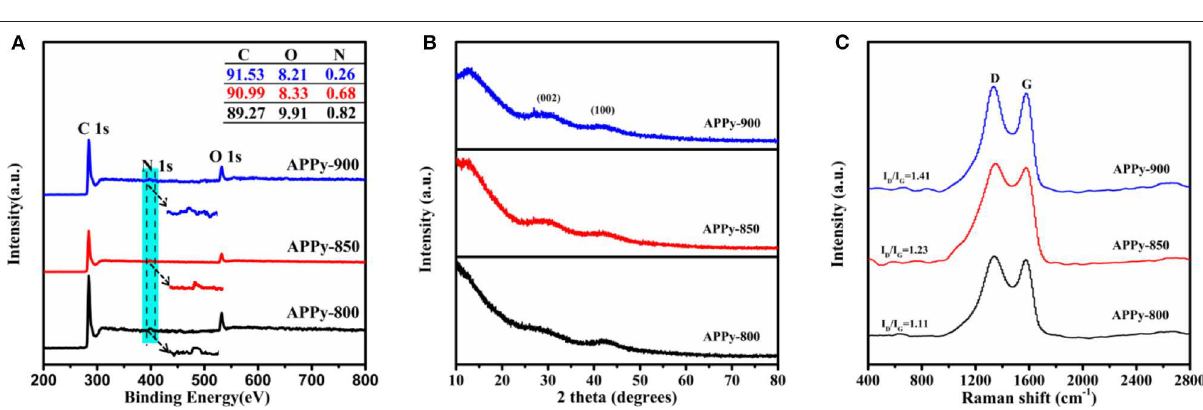
FIGURE 3 | (A) X-ray photoelectron spectroscopy (XPS) spectra, and inset is a table of detailed elements in materials. (B) X-ray diffraction (XRD) patterns of the APPy porous carbons. (C) Raman spectra of the APPy porous